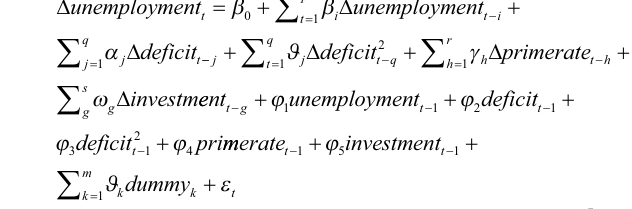
The coefficients φ long-run coefficients and β coefficients. The ARDL F-bounds test is applied to the joint hypothesis that φ exceeds the upper bound critical F value of the bounds test, there is a long-run relationship; otherwise there is none. And the ARDL error correction representation can be The error terms ε and ε are assumed to follow a , ε , ε 1 t 2 t 3 t 4 t multivariate normal distribution. d is the maximum order of integration, which is determined by using the standard Augmented Dickey-Fuller (ADF) test and the Kwiakowski, Phillips, Schmidt and Shin (KPSS) test that structure their null hypothesis differently. The test for Granger non- causality tests the null hypotheses that γ = 0, α = 0, φ = 0, 1 i 1 h 1 ɡ β = 0, α = 0, φ = 0, γ = 0, φ = 0, β = 0, β = 0, γ = 0, α = 0, 2 j 2 h 2 ɡ 3 j 3 ɡ 3 i 4 j 4 i 4 h for i = 1, …, p; j = 1, …, q, and h = 1…, r and excluding the augmenting maximum lag, d.